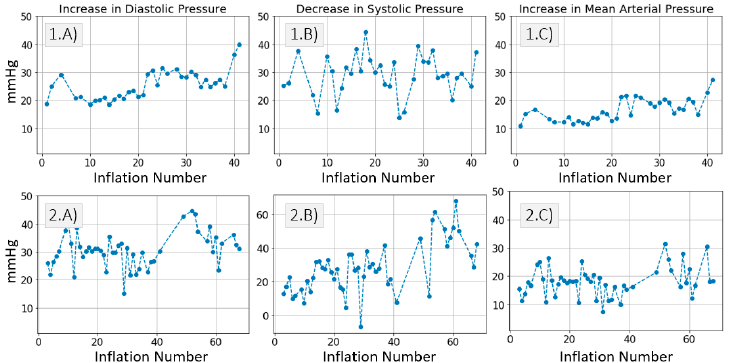
Figure 5. ( A ) Maximum increase in distal diastolic pressure per inflation. ( B ) Maximum decrease in distal systolic pressure per inflation. ( C ) Maximum increase in distal mean arterial pressure per inflation. Results are displayed for Patient 1 data and Patient 2 data respectively.